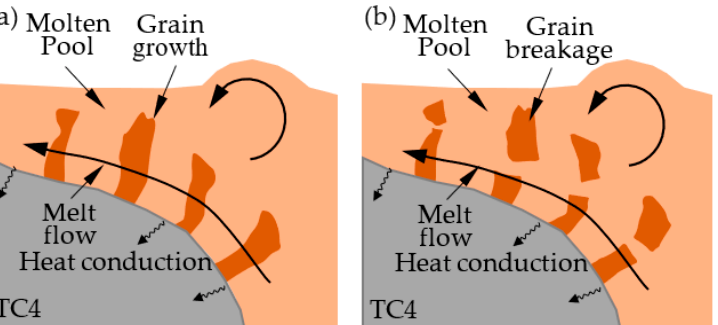
Figure 21. Schematic diagram of grain evolution in arc zone: ( a ) grain growth; ( b ) grain breakage.